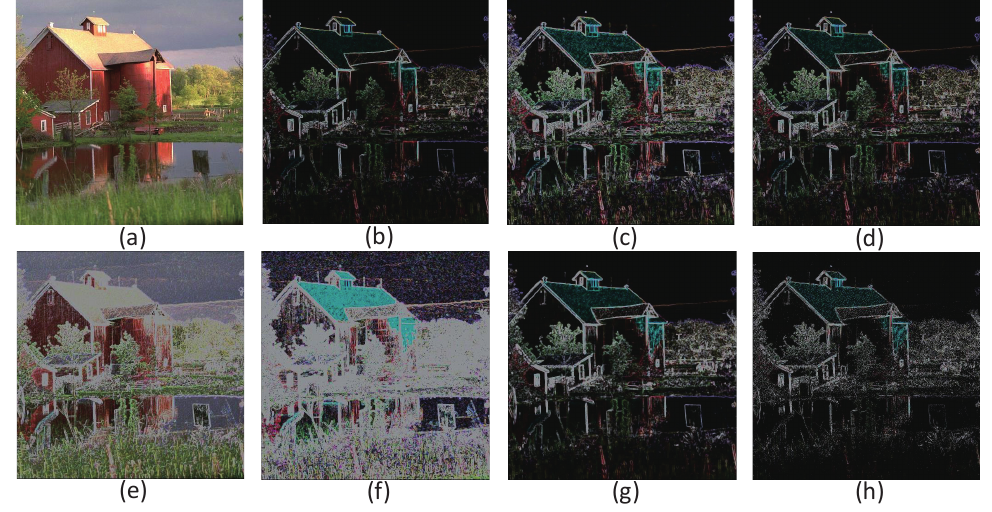
Figure 14. The realization of color image edge extraction.( a ) Original image, ( b ) Prewitt operator, ( c ) Proposed Prewitt operator, ( d ) Sobel operator, ( e ) Proposed Sobel operator, ( f ) Kirsch operator, ( g ) Robert operator, ( h ) Laplacian